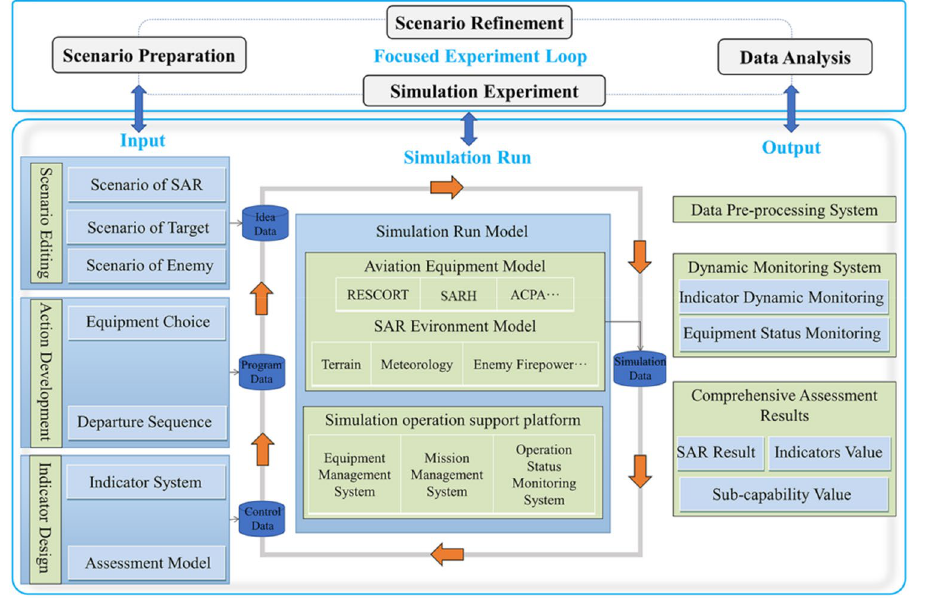
Figure 3. Simulation test